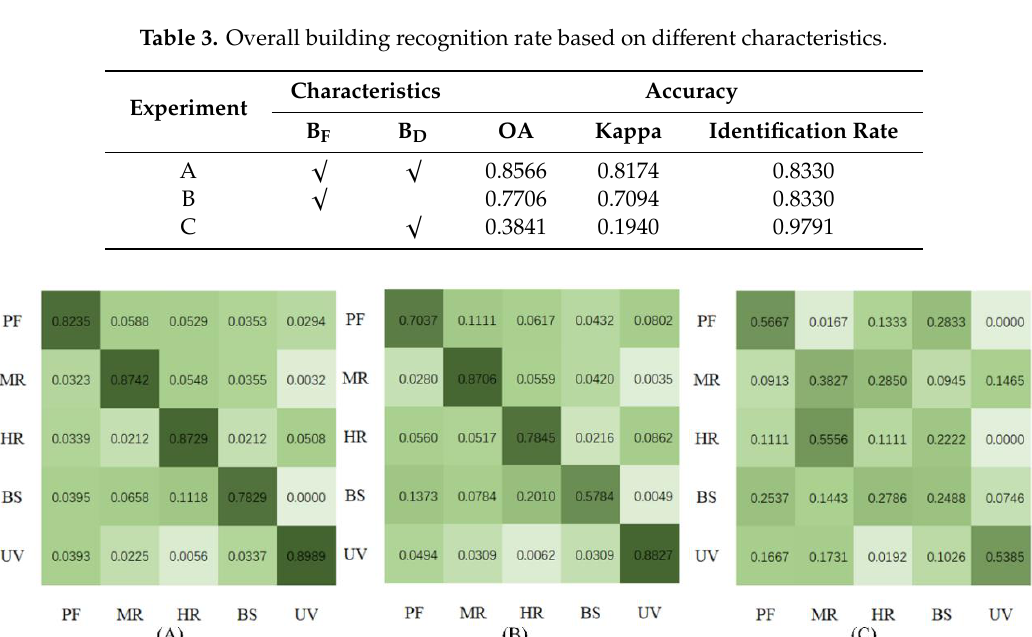
Figure 5. Confusion matrix of the building function identification results. ( A ) Results derived by combining the spatiotemporal interactions among the buildings and the building vitality characteristics. ( B ) Results based on the spatiotemporal interaction characteristics only. ( C ) Results based on the building vitality characteristic only.